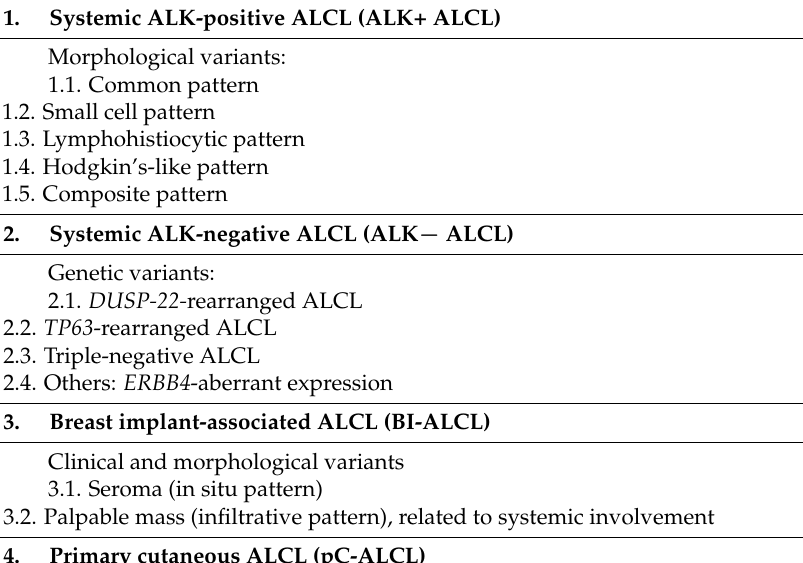
Table 1. Anaplastic large cell lymphoma (ALCL): classification and